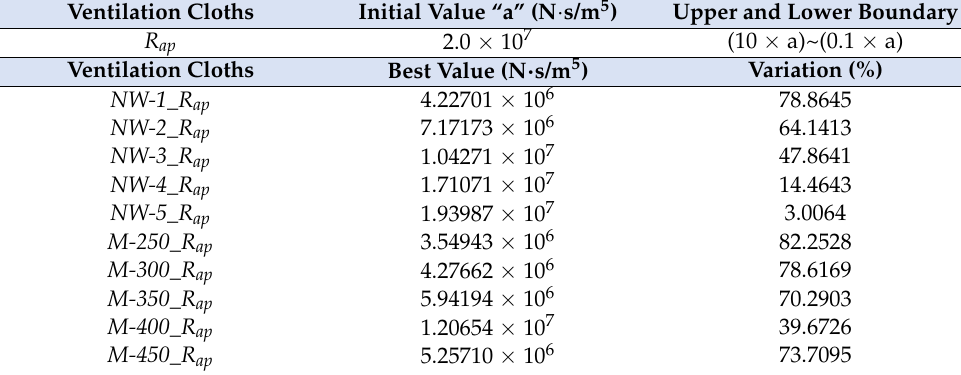
Table 7. Optimized values of acoustic resistance of various ventilation